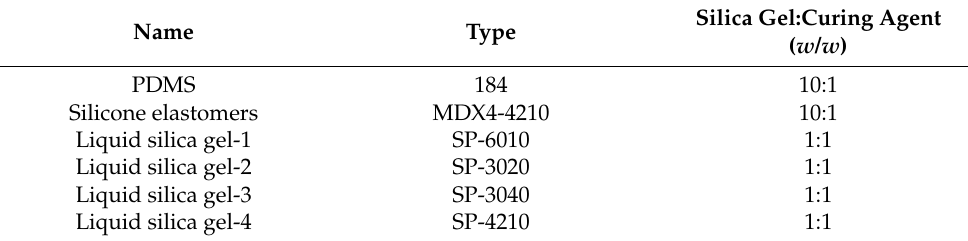
Table 1. Compositions of different materials for preparing male